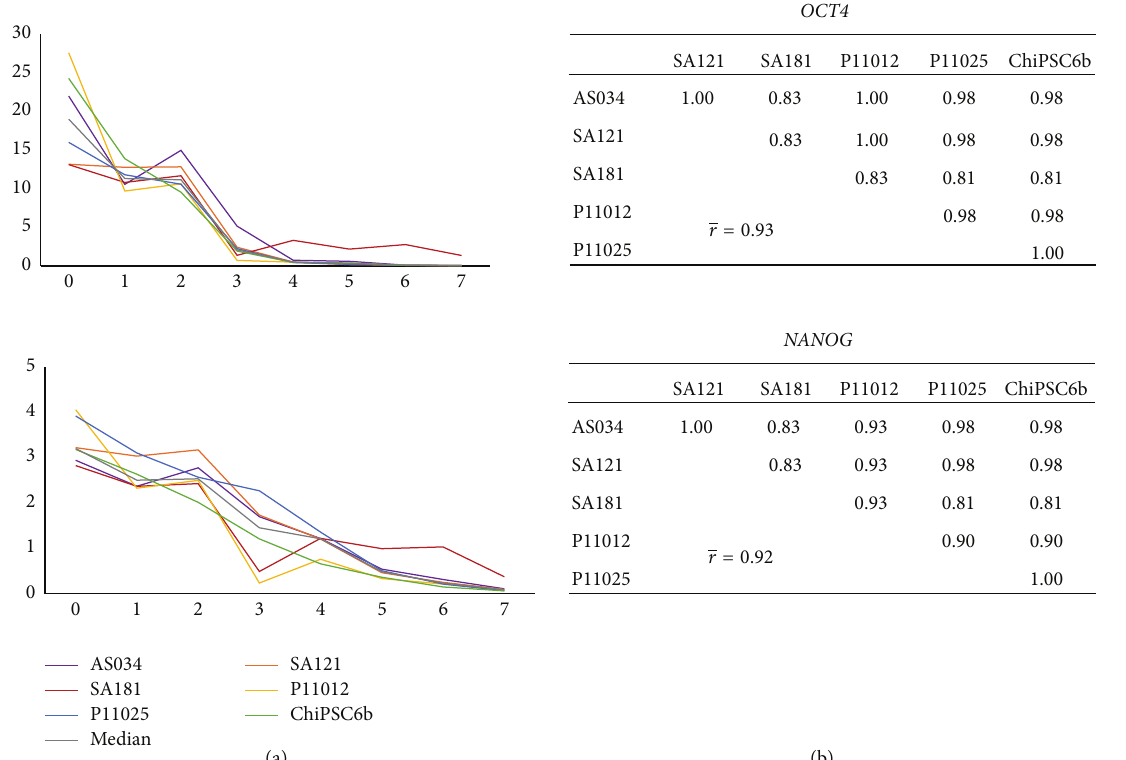
Figure 3: Gene expression profiles of the pluripotent markers OCT4 and NANOG . (a) The 𝑥 -axis indicates the days during differentiation and the 𝑦 -axis indicates relative quantification (RQ) where the calibrator’s RQ = 1. The colored lines show the results from each individual hPSC line and the grey line indicates the calculated median value of the RNA level. (b) Correlation tables show very strong correlations between the cell lines, with an average pairwise correlation of 0.93 for OCT4 and 0.92 for NANOG for the interval of day 0 to day 7.